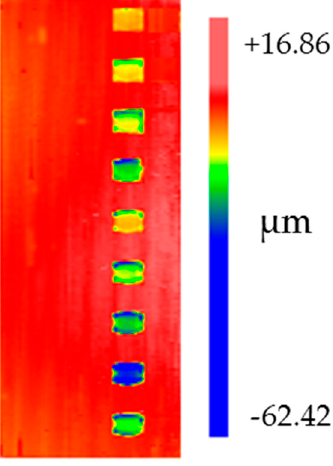
Figure 7. Removal functions under different parameters.